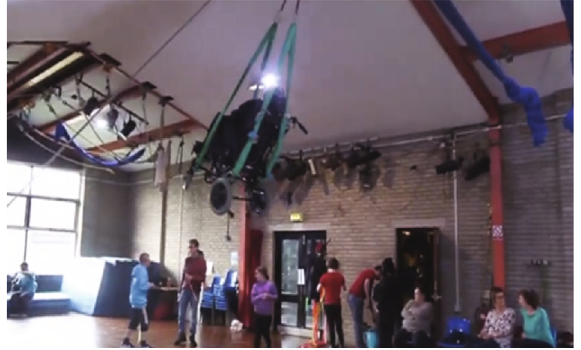
Figure 6: Participant in wheelchair suspended from the roof [35]. Figure